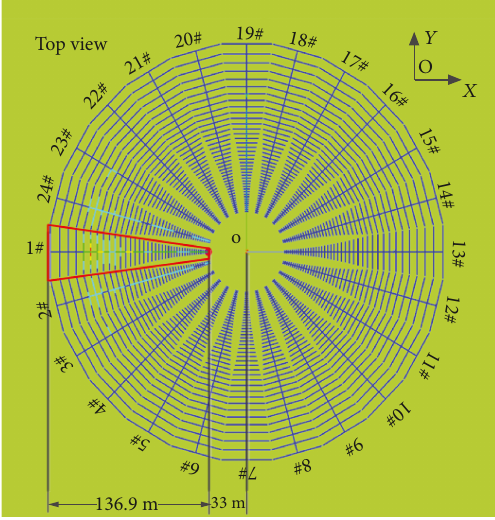
Figure 6: The circular array composed of a nonlinear LPDA. The red border is the design range of the